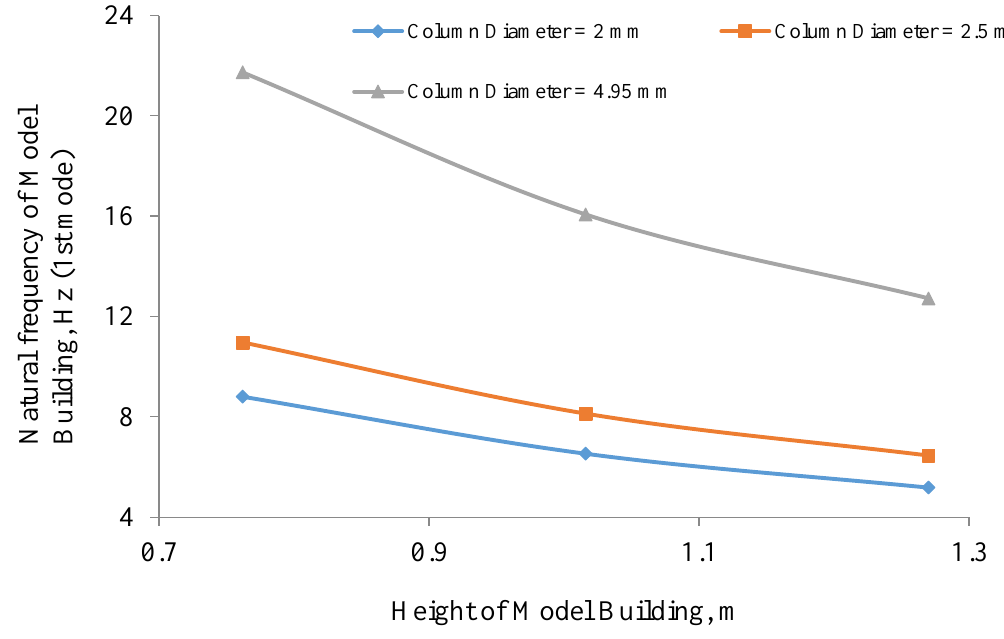
Fig. 3. Variation of Natural Frequency with Building